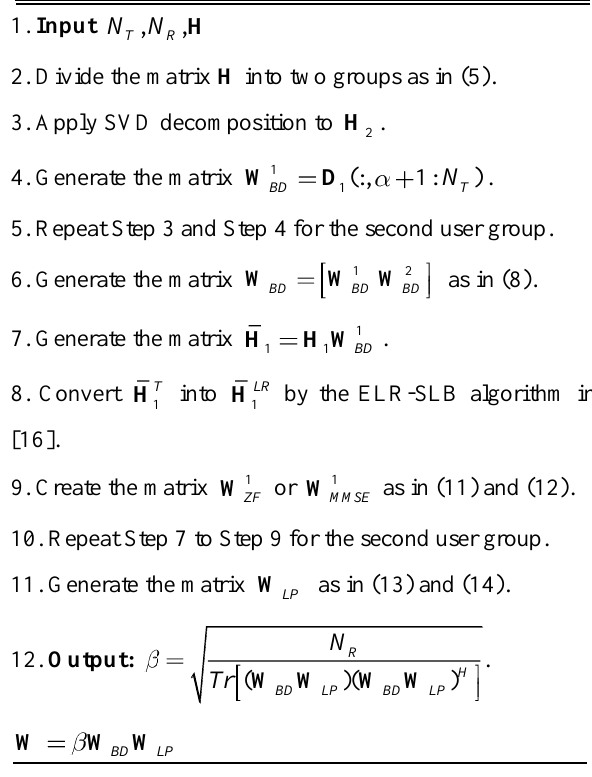
Algorithm 1: The BD-LR-ZF and BD-LR-MMSE precoding